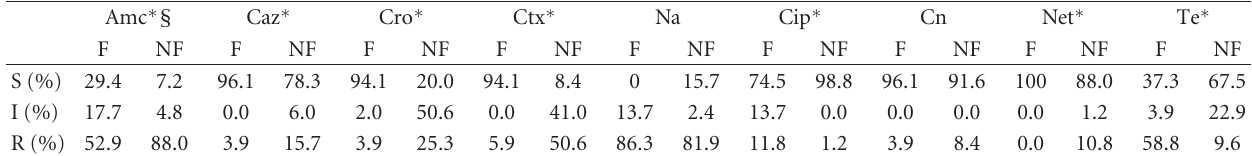
Table 1: Frequency of resistance, intermediate susceptibility, and susceptibility to the antibacterial drugs tested in fermenters and nonfermenters.